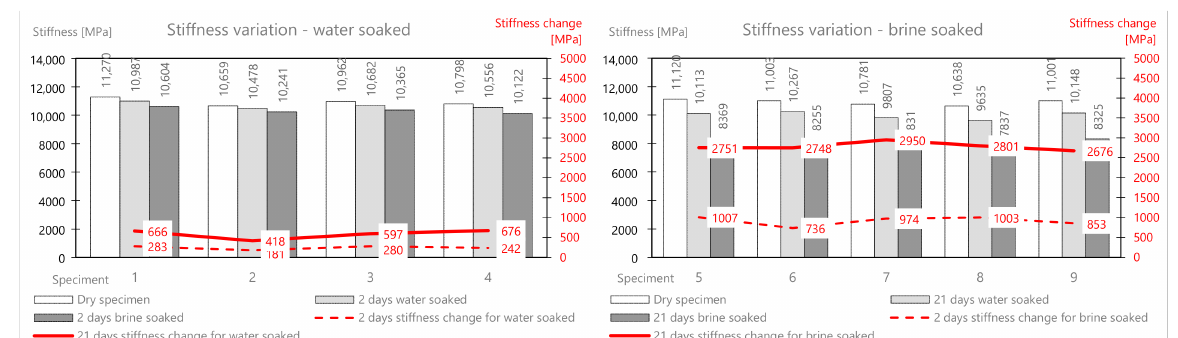
Figure 6. AC11S mix stiffness variation via water and brine